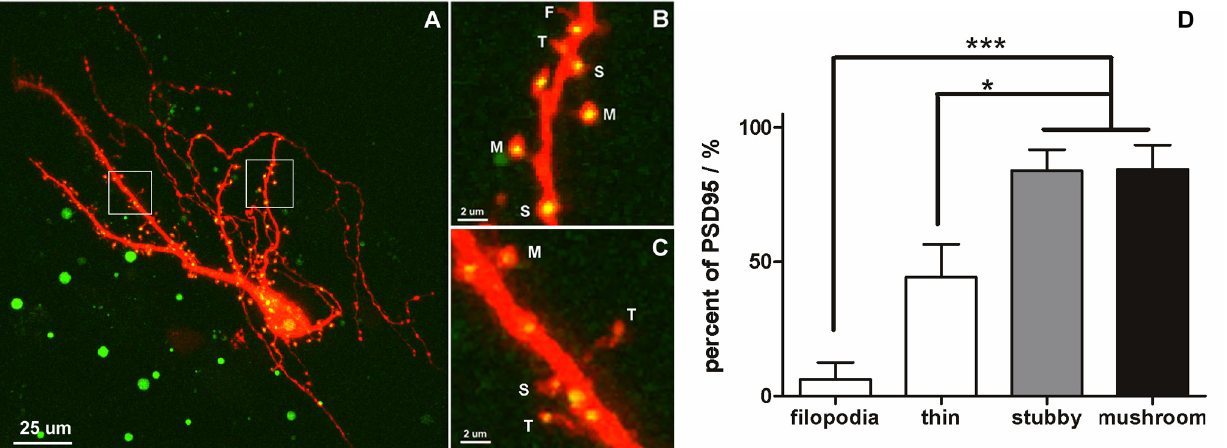
Fig 2. In vivo images of DsRed2 and PSD95-GFP double-labeled spiny neurons in X . laevis tadpoles. (A) A spiny neuron was labeled by DsRed2 and PSD95-GFP. The postsynaptic specializations on spines are shown as yellow puncta. Green dots are developing melanocyte pigmentation not fully inhibited by phenylthiocarbamide (PTU). (B, C) High magnification views showing the different types of dendritic spines of the spiny neuron in (A). F: filopodia; T: thin spine; S: stubby spine; M: mushroom spine. The yellow puncta represent synaptic contacts, most of which were on stubby and mushroom spines. (D) Statistical analysis of the percentage of PSD95-GFP on different types of dendritic spines. Stubby and mushroom spines exhibited a higher number of PSD95-GFP puncta than filopodia and thin spines. Bars indicate mean ± SEM. N = 4 neurons with 9 dendrites were used for colocalization analysis of PSD95-GFP. The significance levels were * P < 0.05, ** P < 0.01, and *** P < 0.001.